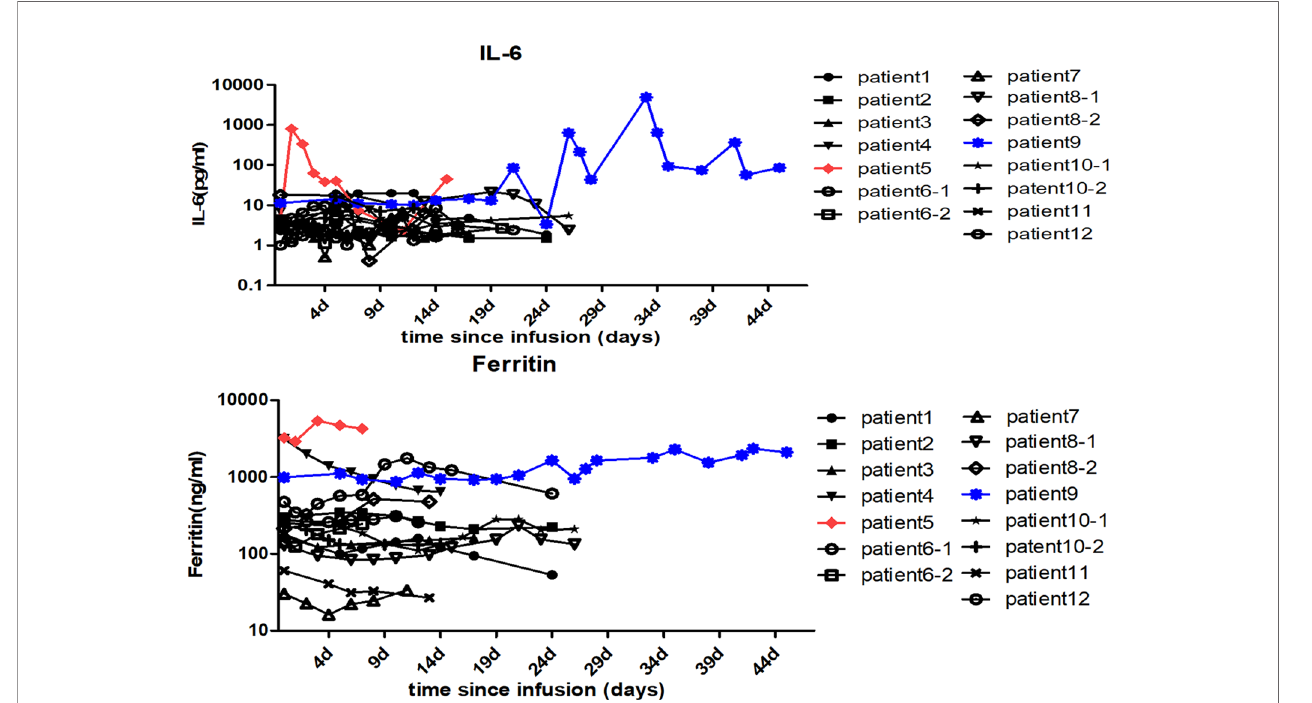
FIGURE 3 | Changes in the patients ’ serum cytokine levels after anti-CD30 CAR-T cell infusion. The serum IL-6 and ferritin levels of each patient were assessed before and at serial time points after anti-CD30 CAR-T cell infusion. The red and the blue lines, respectively, represent patient 5 and patient 9 with higher IL-6 and ferritin levels than the